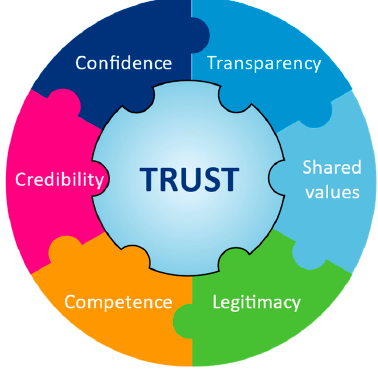
Figure 2. Parameters that underpin trust. Society’s trust in an industry or activity is underpinned by a range of factors, including confidence in the transparency of the industry’s operations, the credibility, legitimacy, and competence of its leaders and practitioners, and the relevance to society of the values that it espouses.